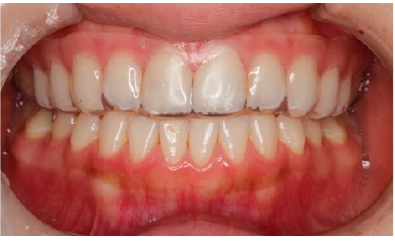
Figure 2. Participant wore a mouthguard that made contact with all teeth with light clenching.